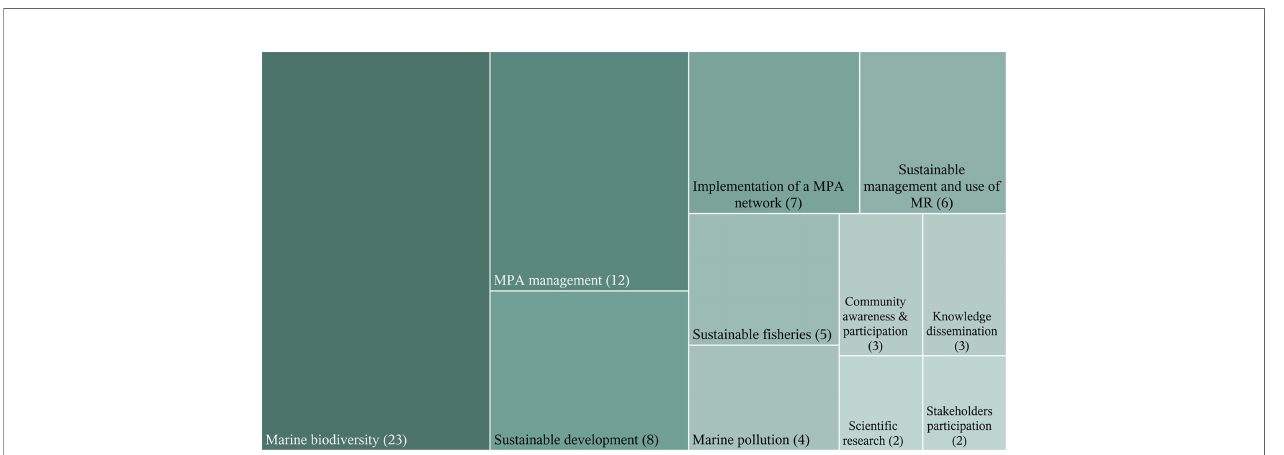
FIGURE 2 | The comprehensiveness of the 37 prioritized indicators in relation to the identi fi ed national goals (from MPAs management plans; for further details see Supplementary Table 4 ). Goals are followed by the number of indicators serving them (in parenthesis). The area and shade of the polygons follow the number of indicators available for each identi fi ed goal. MR, Marine